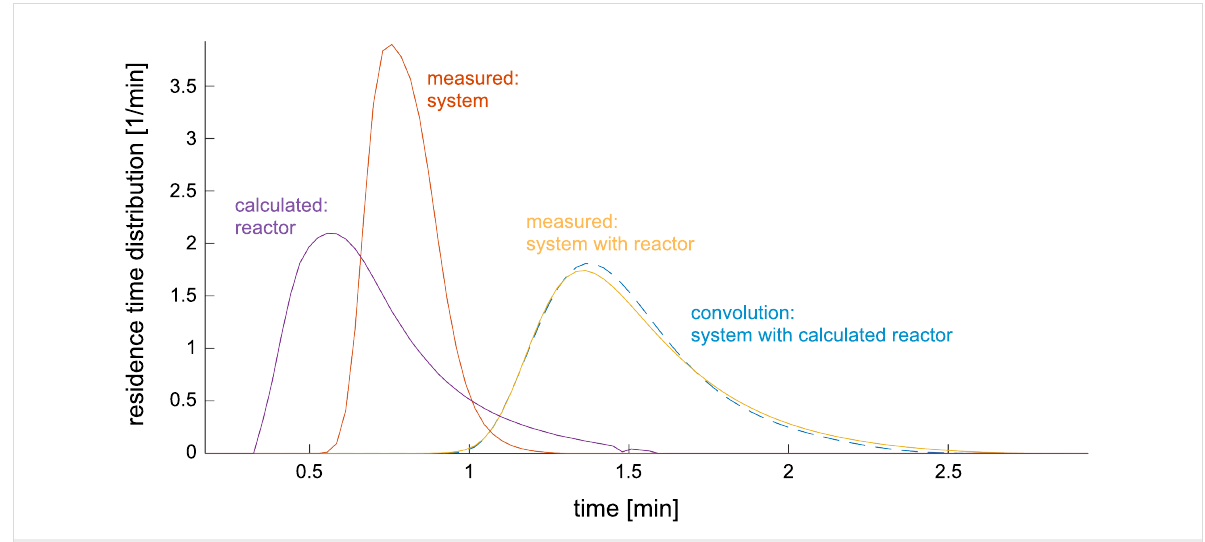
Figure 15: Residence time distributions of the stand-alone system and the reactor integrated into the system. Flow rate: 0.35 mL/min, reactor volume: 0.35 mL, filled with 74 to 80 mg of particles, 5 µL of 10 mM potassium phosphate buffer was used as tracer and injected with a speed of 1 mL/min.